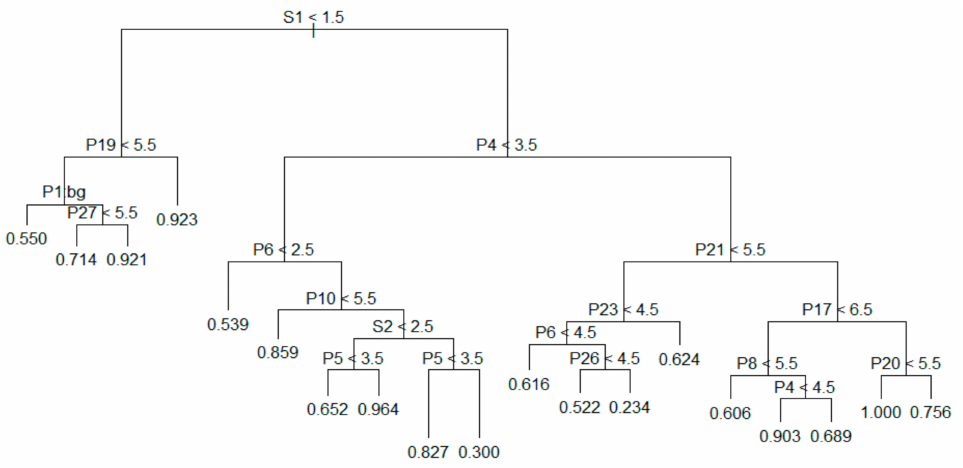
Figure 1. Classification tree of the customers’ loyalty in the quantitative perspective. Source: authors’ study.